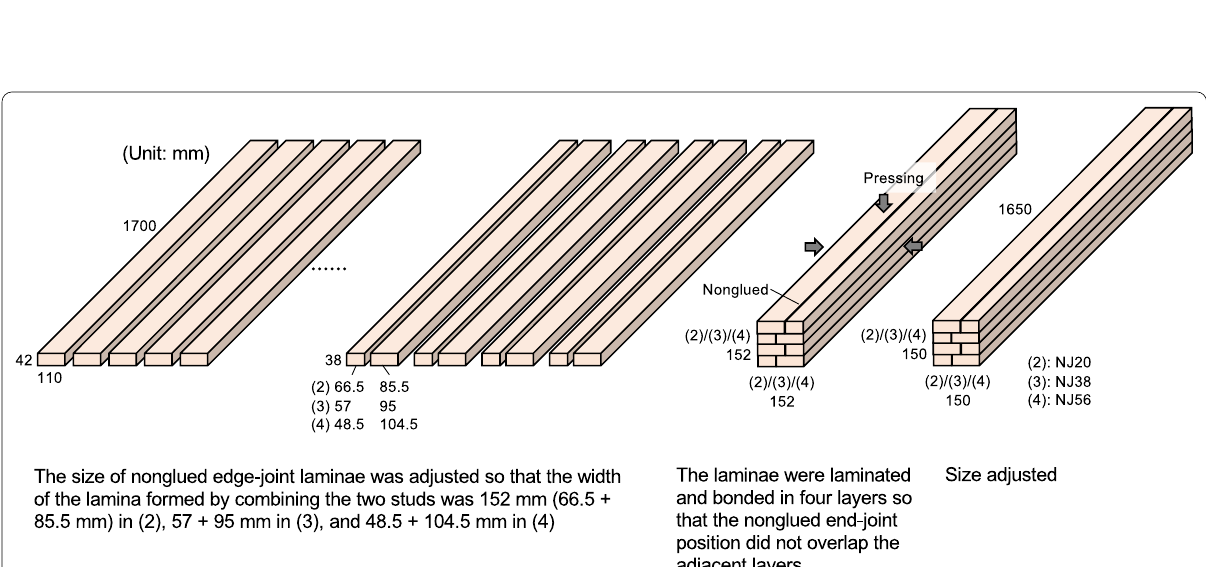
Fig. 3 Manufacturing procedure of the nonglued edge-joint glued laminated timber (NJ20, NJ38 and NJ56)